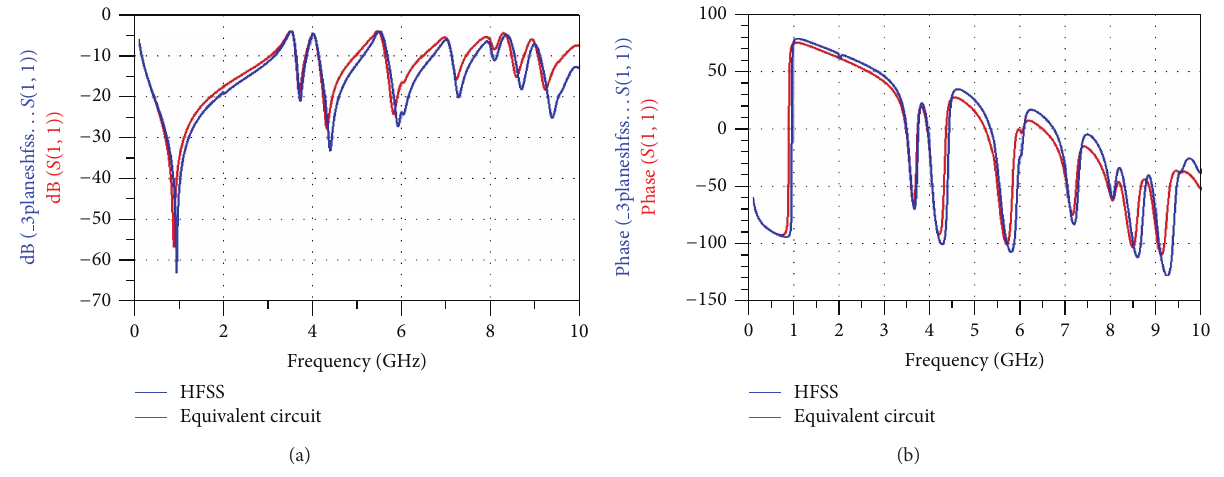
Figure 20: 𝑆 11 of single via structure in multilayer: (a) amplitude; (b)